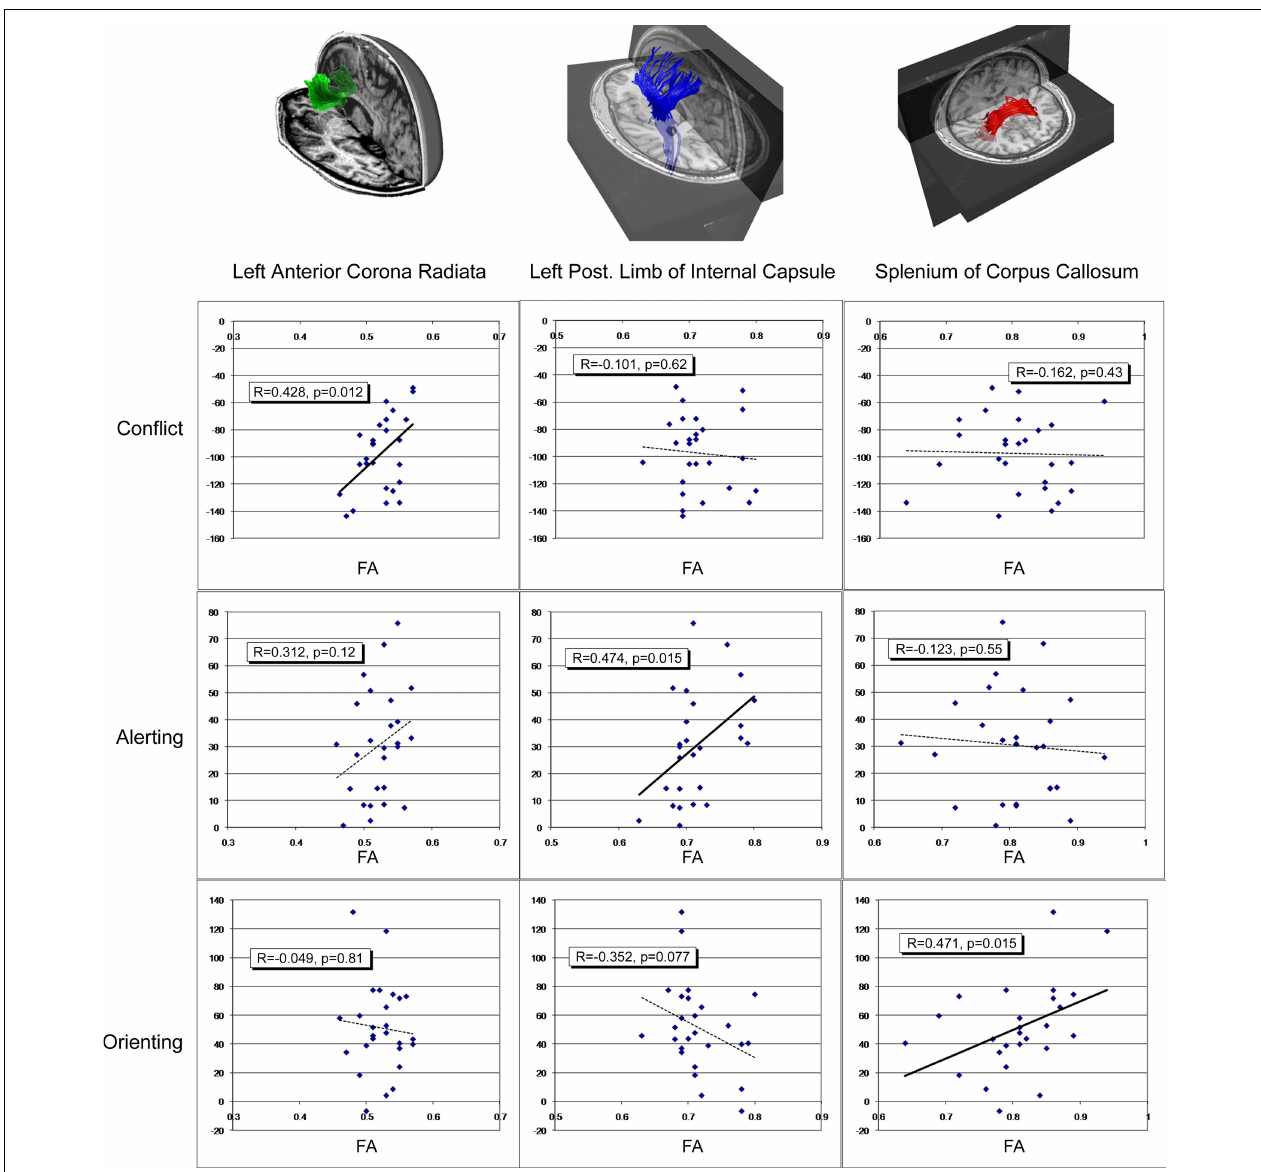
FIGURE 3 | Scatter plots demonstrating the relationship between functional components of attention identifi ed in the Attention Network Task (ANT), and average fractional anisotropy (FA) of relevant regions of interest. Each row of graphs illustrates results for the three components of attention: the confl ict component (top row), the alerting component (second row), and the orienting component (third row), each column of graphs illustrates